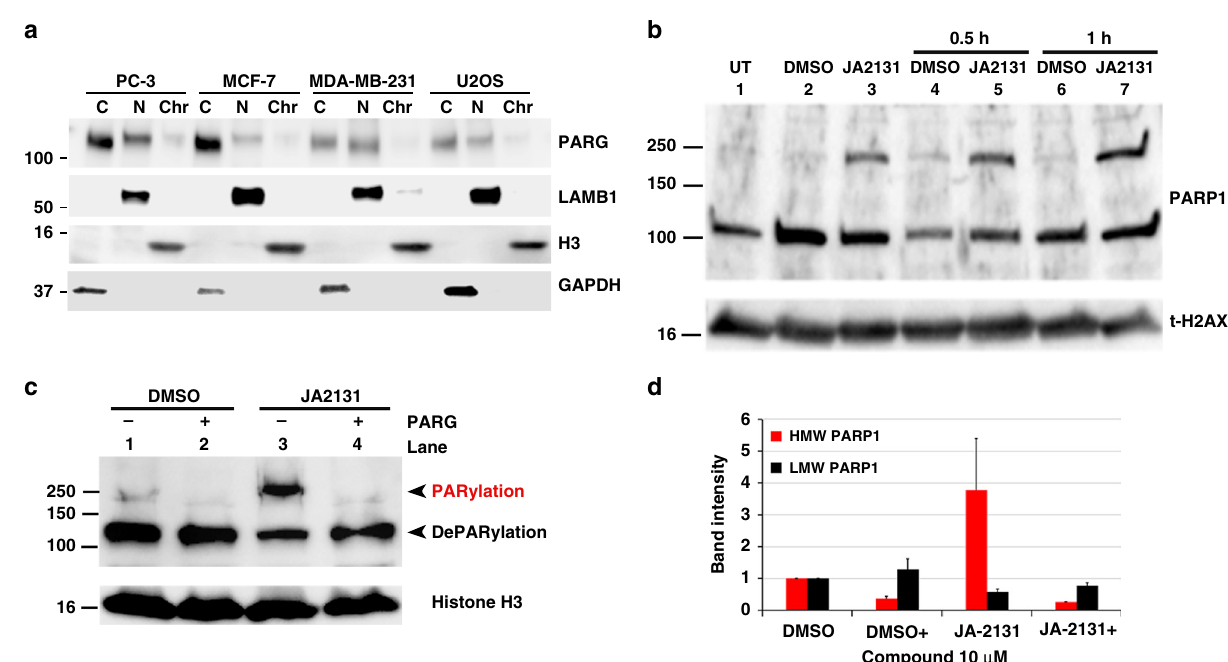
Fig. 4 JA2131 induces hyperPARylation of PARP1 . a Subcellular PARG protein expression patterns in cultured cells. Subcellular fractionated lysates were immunoblotted with anti-PARG, (upper panel) followed by nuclear (N) marker anti- Laminin Subunit Beta 1 (LAMB1, upper middle panel), chromatin (Chr) marker anti-Histone H3 (H3, lower middle panel) and the cytoplasmic (C) marker anti- Glyceraldehyde 3-phosphate dehydrogenase (GAPDH, lower panel) b PC3 cells were treated with DMSO or PARG inhibitor JA2131 (2131) for 2 h then irradiated with 7 Gy and allowed to recover for 0.5 h or 1.0 h before lysis and subcellular fractionation. Chromatin bound cell-extracts were analyzed with anti-PARP1 antibody (upper panel) followed by probing with total Histone H2AX (t-H2AX, lower panel) as the loading control. c DMSO or 2131-treated PC3 cells were irradiated and recovered for 2 h as above, chromatin fractions were then incubated with or without puri fi ed PARG enzyme (±PARG) for 30 min at 37 °C then immunoblotted with anti-PARP1 (upper panel) and then with anti-histone H3 (lower panel) as loading control. d Quantitative analysis of western blot of b , where expression of PARP1 levels in DMSO treated was normalized to 1. High molecular weight (HMW) in red PARP1 is signi fi cantly decreased in the presence of puri fi ed truncated PARG protein. The low molecular weight in black PARP1 bands are not signi fi cantly affected, n = 3. Plus denotes added puri fi ed PARG enzyme. Source Data are provided as a Source Data fi